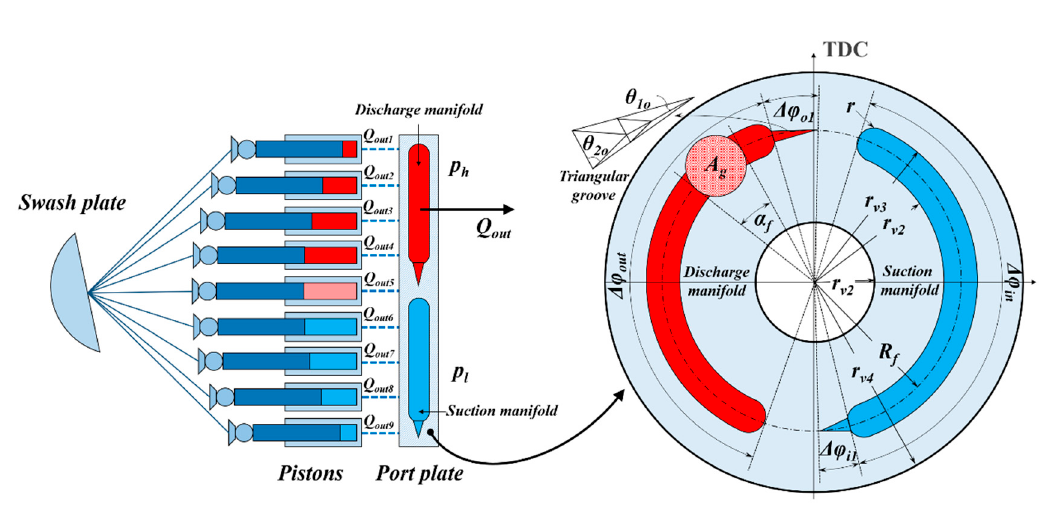
Figure 2. Scheme of the simulation model.